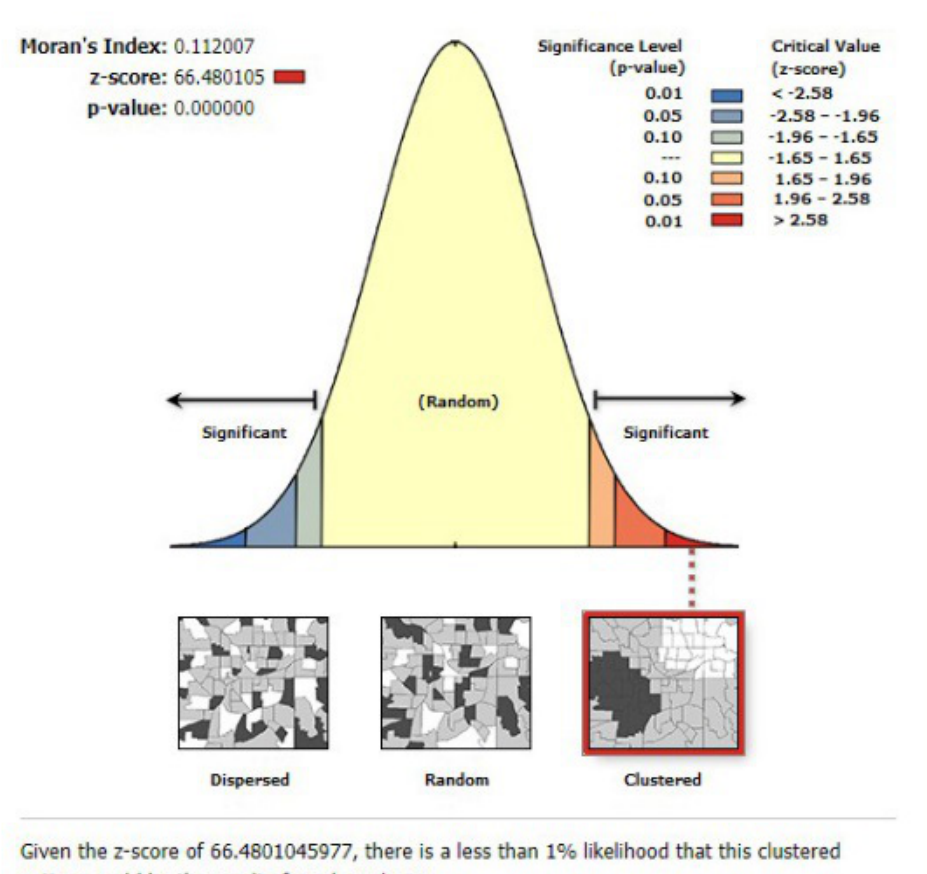
Fig. 28 Spatial autocorrelation report of